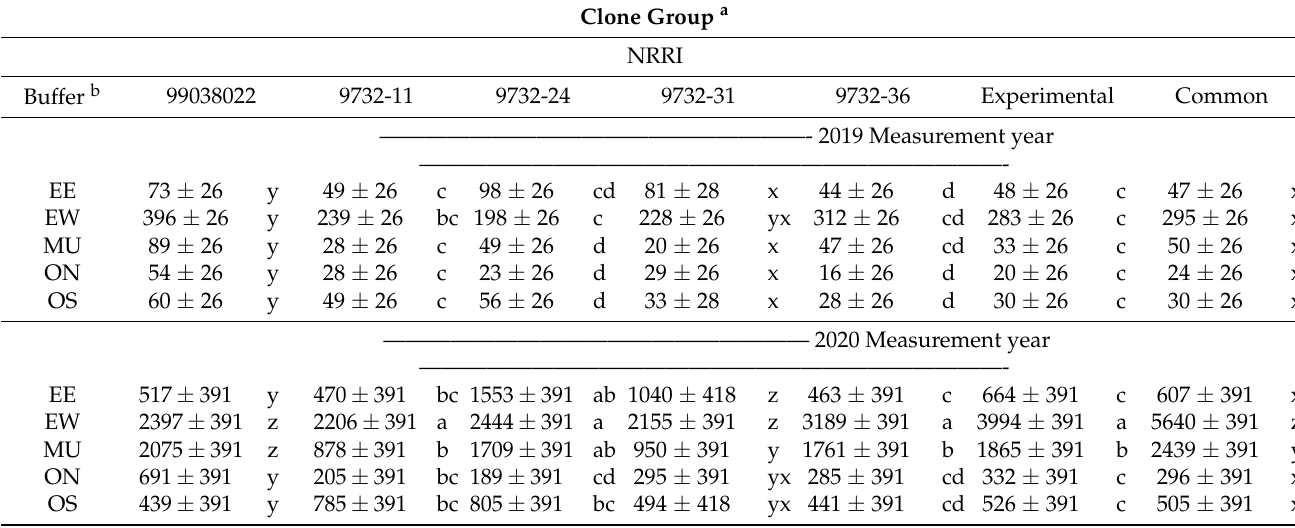
Table 6. Volume (cm 3 ) ( ± one standard error) of three poplar clone groups tested in five phytoremediation buffer systems (i.e., phyto buffers) established in 2019 (i.e., the 2019 Buffer Group) in the Lake Superior watershed of the Upper Peninsula of Michigan, USA. Trees were measured following the 2019 and 2020 growing seasons. Volume values with different letters within a clone column across measurement years are different at p <